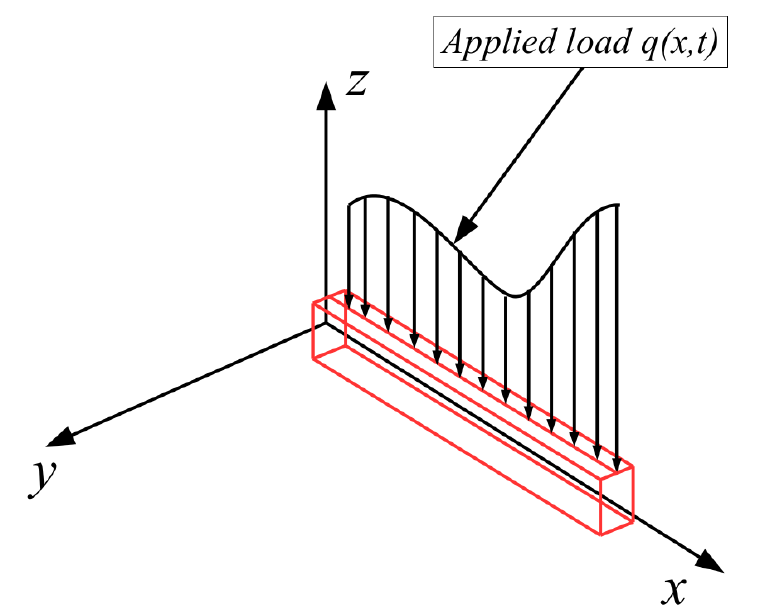
Figure 1. The coordinate system of a structural beam along with the notation used in this